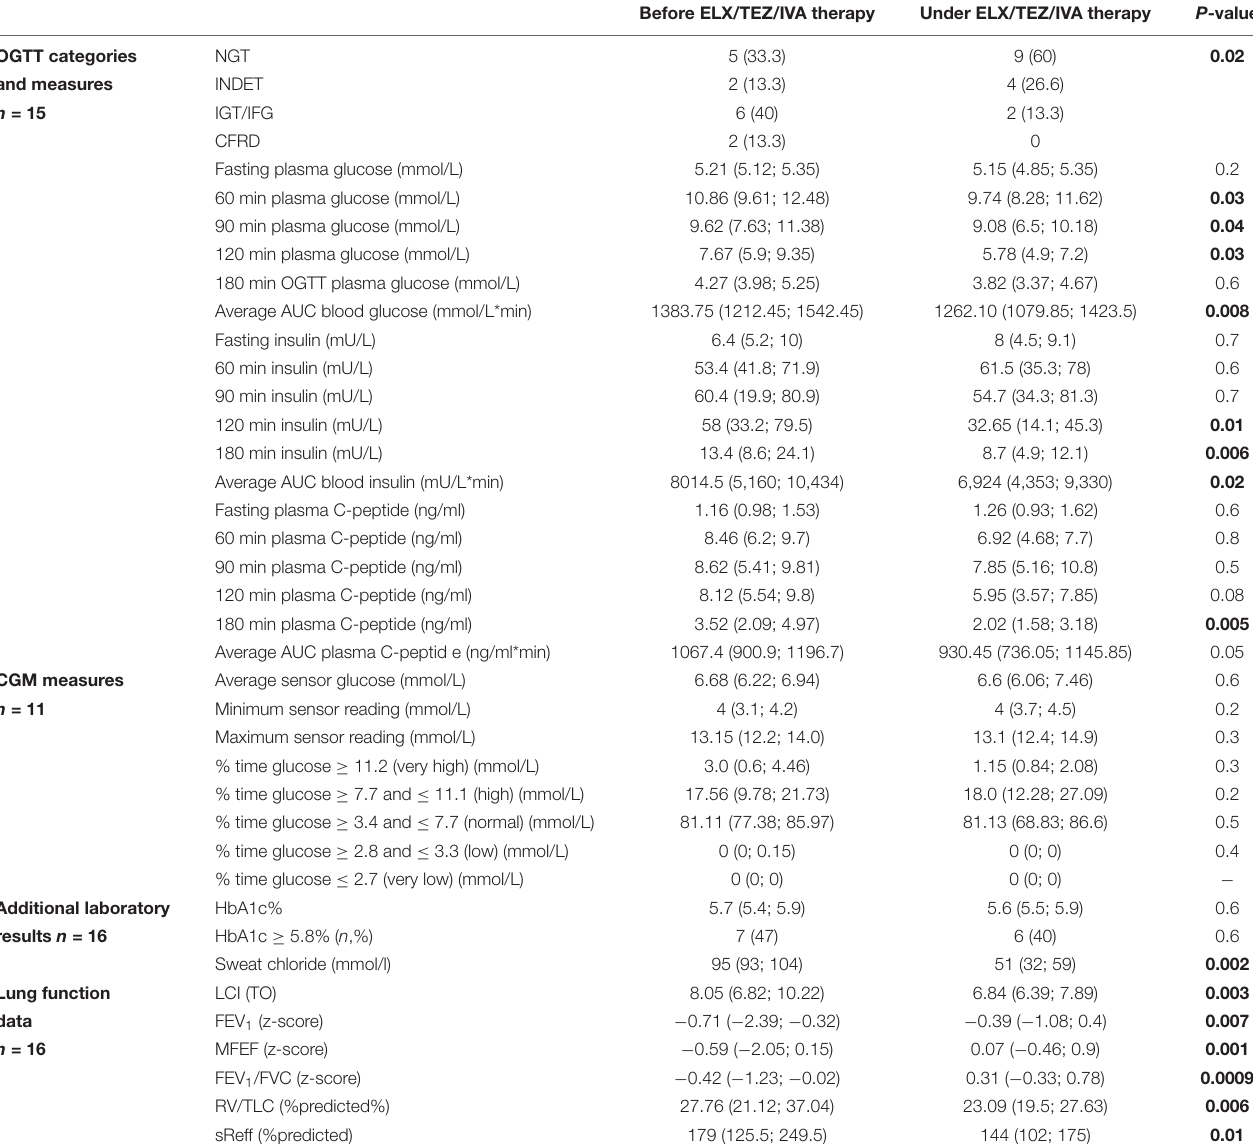
TABLE 2 | Differences in glucose tolerance (OGTT and CGM) and lung function before and after initiation of ELX/TEZ/IVA therapy in people with cystic fibrosis. Before ELX/TEZ/IVA therapy Under ELX/TEZ/IVA therapy P